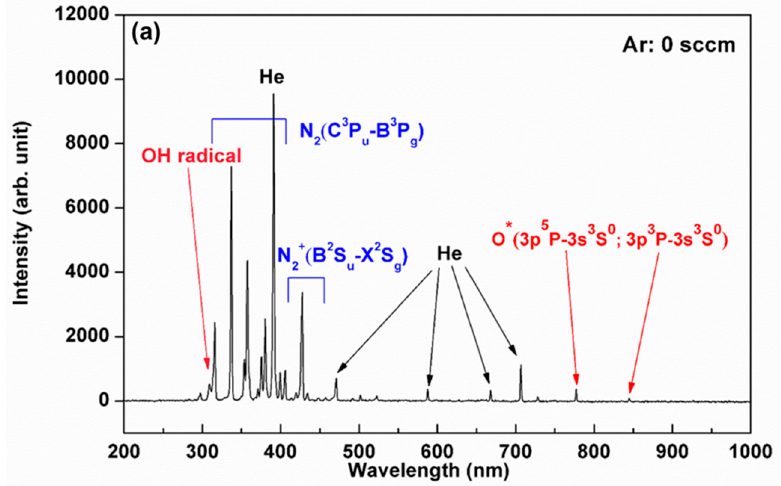
Figure 2. CAPJ temperature keeps steady for at least 30 min. Temperature changes of CAPJs operated at different applied voltages ranging from 6.5 to 9.5 kV under a fixed He gas flow rate of 5 slm. The temperature was detected at the position of 1 cm below the downstream of